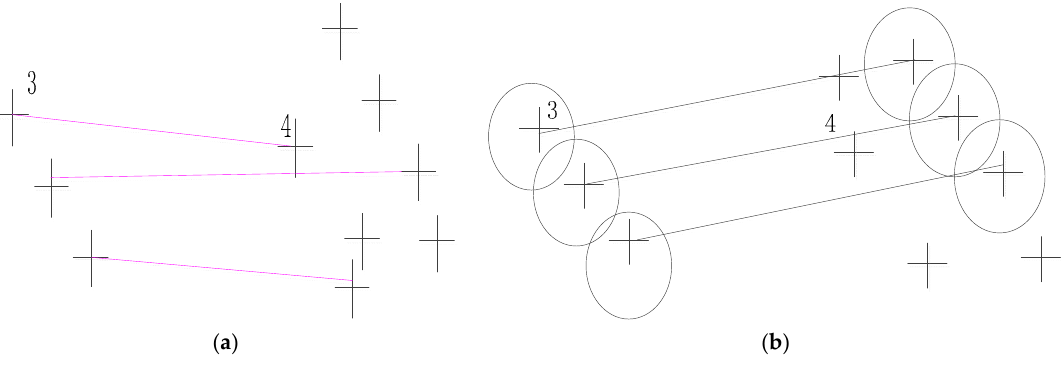
Figure 5. The advantage of geometric SIFT. ( a ) The error match points in the reference image; ( b ) The error match point in the registering image and the projection with a circle of radius R by the points 3 and 4 in the reference image.